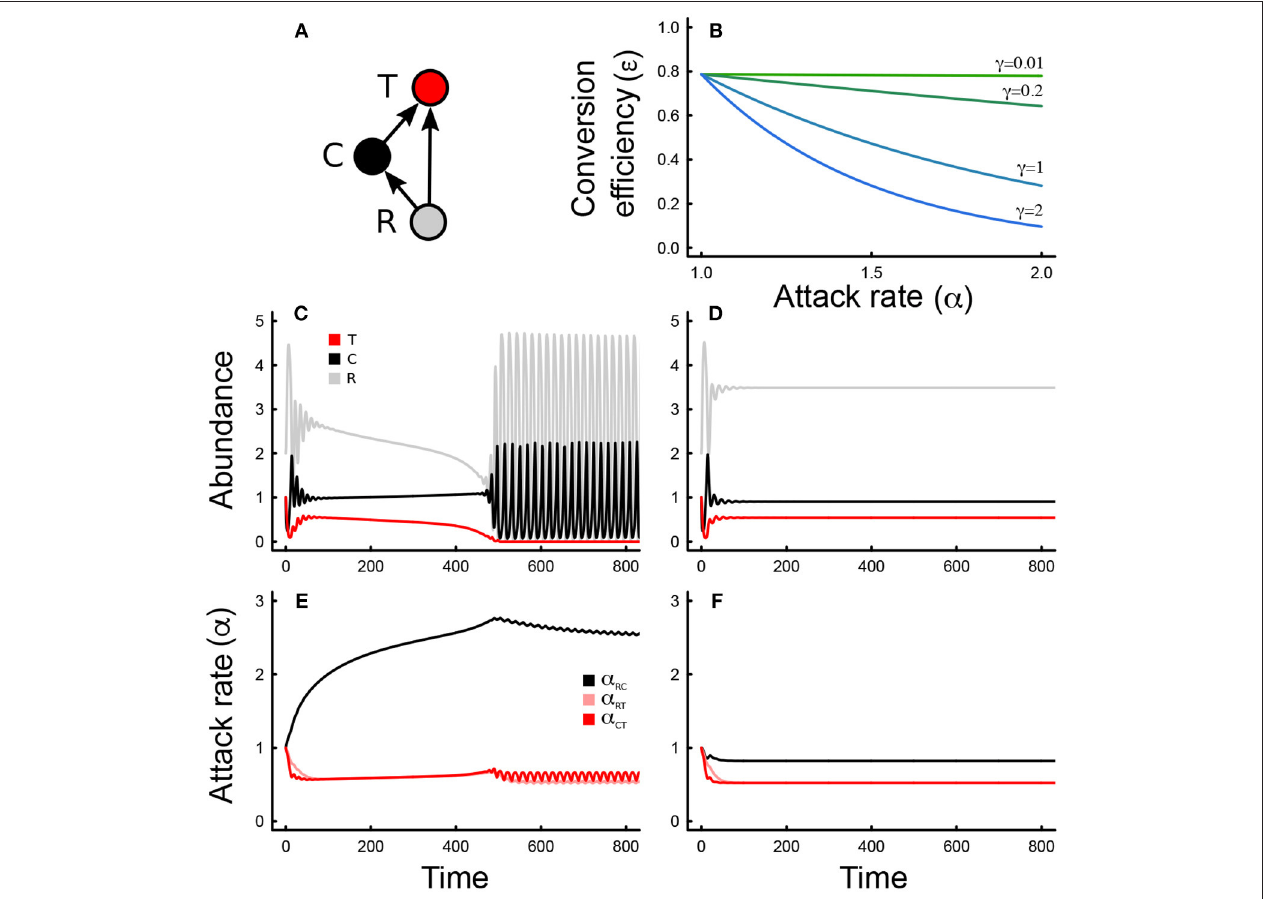
FIGURE 1 | (A) Depiction of the omnivory food web module, where T is the top predator (red), C is the intermediate consumer (black), and R is the basal resource (gray). Colors are consistent across all figures. (B) Tradeoff between conversion efficiency ( ε ) and attack rate ( α ) for different levels of the tradeoff magnitude ( γ ). (C) Changes in abundance over time for all three species, and all evolving attack rates (E) , for a low consumer tradeoff ( γ RC = 0.01). (D,F) Same as in (C,E) but for a large consumer tradeoff ( γ RC = 2). Parameter values in Table 1